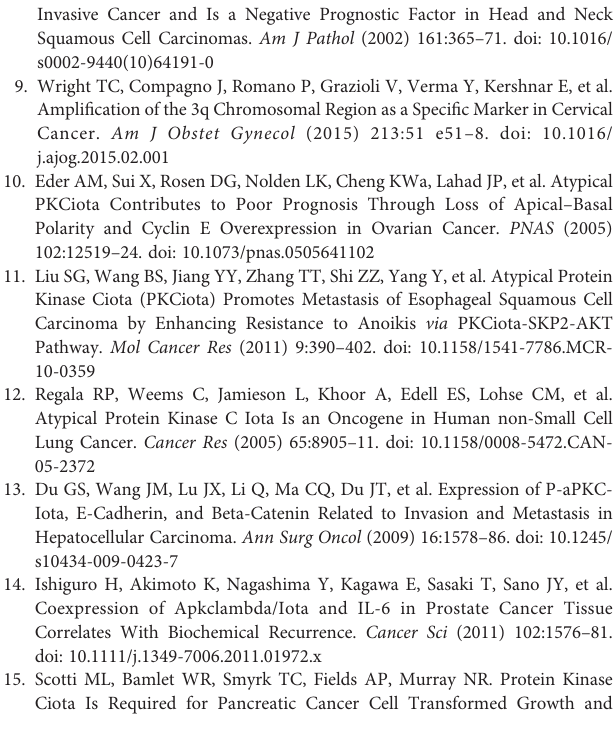
overexpression on the cell cycle progression of HeLa and SiHa cells without radiotherapy. Data are shown as the mean ± SD from three independent experiments. NS, not signi fi cant.